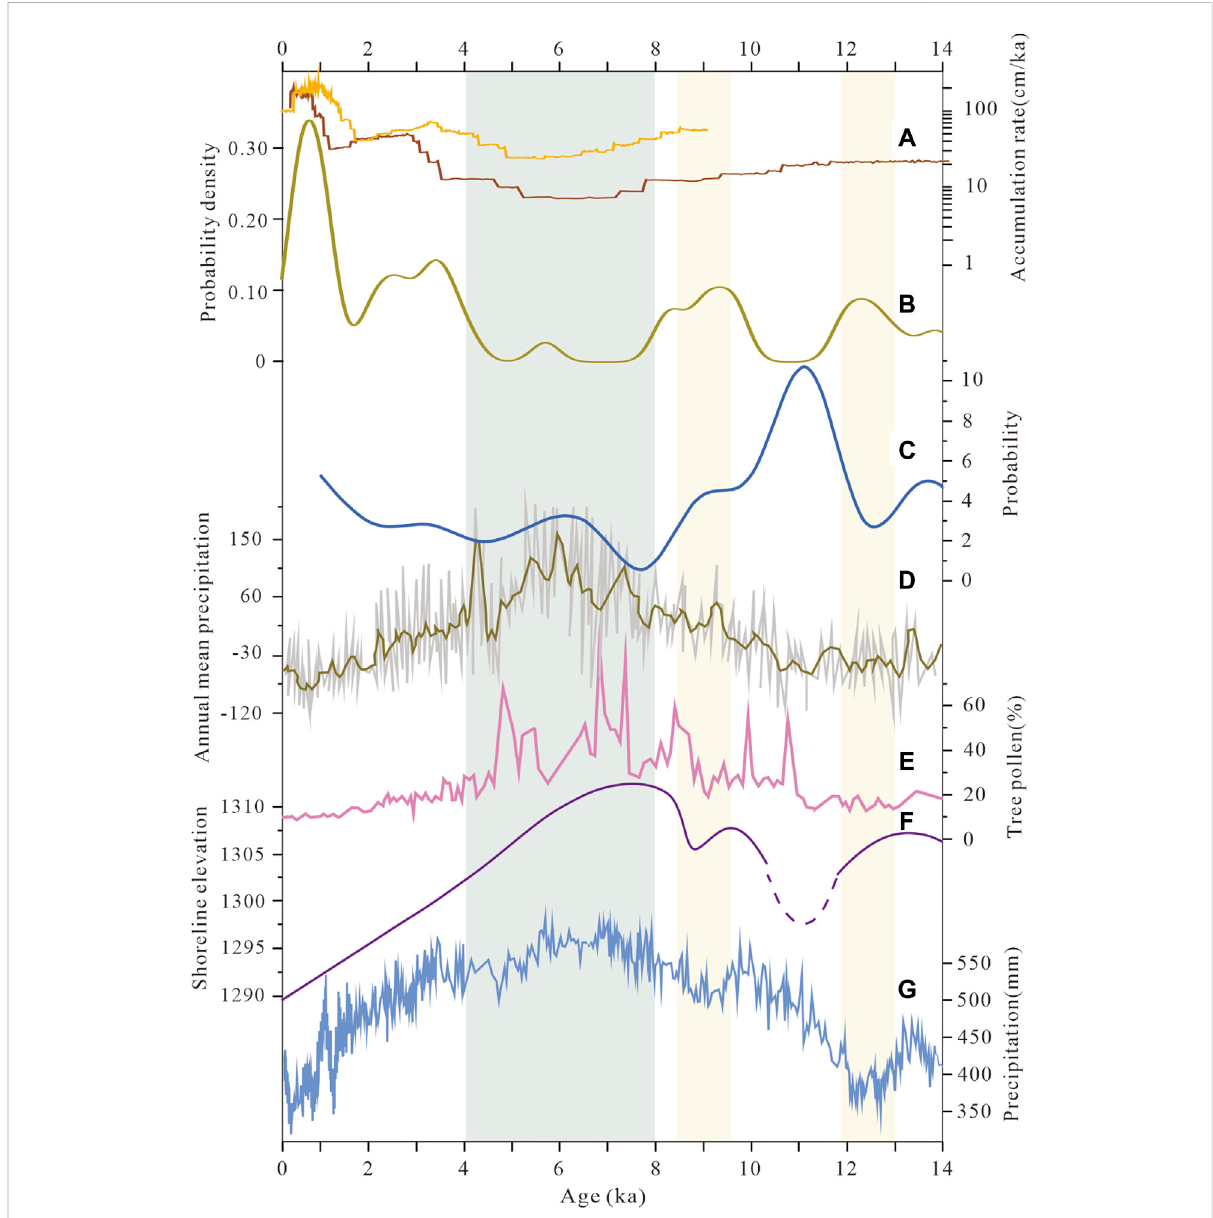
FIGURE 7 The aeolian – palaeosol recordsinthecurrentstudy and otherrecordsintheadjacentareainNETP. (A) Accumulationrates ofEBD1 (yellow line) and EBD2 (red line), and (B) PDF of all luminescence ages of EBD1 and EBD2; (C) PDF of the previously published luminescence ages of aeolian sand over the NETP (Chen et al., 2016); (D) quantitative reconstructed precipitation based on pollen data from Qinghai Lake (Li et al., 2017); (E) tree pollen percentages from Lake Dalianhai (Cheng et al., 2013); (F) water level history of Baijian Lake (Long et al., 2012); and (G) EASM precipitation variation record from Lake Gonghai (Chen et al.,